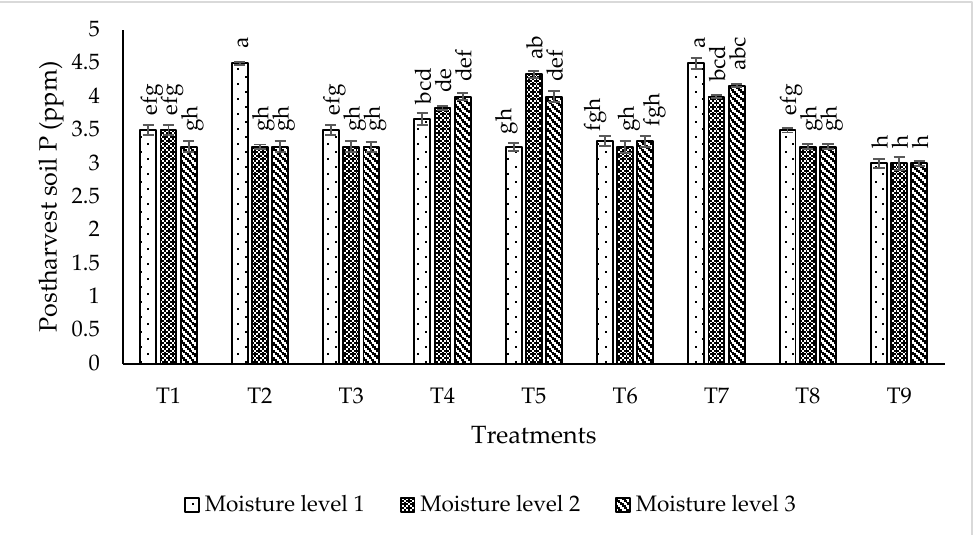
Figure 11. Effect of most efficient strains on post-harvest soil P (ppm) at different moisture levels in glass house experiment. The bars indicate standard error (± SE) of the mean ( n = 3). Means followed by the same letter within the bars are not significantly different at p = 0.05. T1 = RZ22 + RP01 + RS15, T2 = RZ11 + RP01 + RS14, T3 = RZ11 + RP08 + RS14, T4 = RZ11 + RP08 + RS15, T5 = RZ11 + RP01 + RS15,T6 = RZ22 + RP08 + RS14, T7 = RZ22 + RP08 + RS15, T8 = RZ22 + RP01 + RS14, T9 = control, where RZ11 = Mesorhizobium ciceri , RP08 = Enterobacter cloacae , RS14 = Bacillus mojavensis , RS15 = Providencia vermicola , RP01 = Bacillus subtilis , RZ22 = Mesorhizobium ciceri , Moisture level 1 = 55% of Field Capacity, Moisture level 2 = 75% of Field Capacity, Moisture level 3 = 95% of Field Capacity.